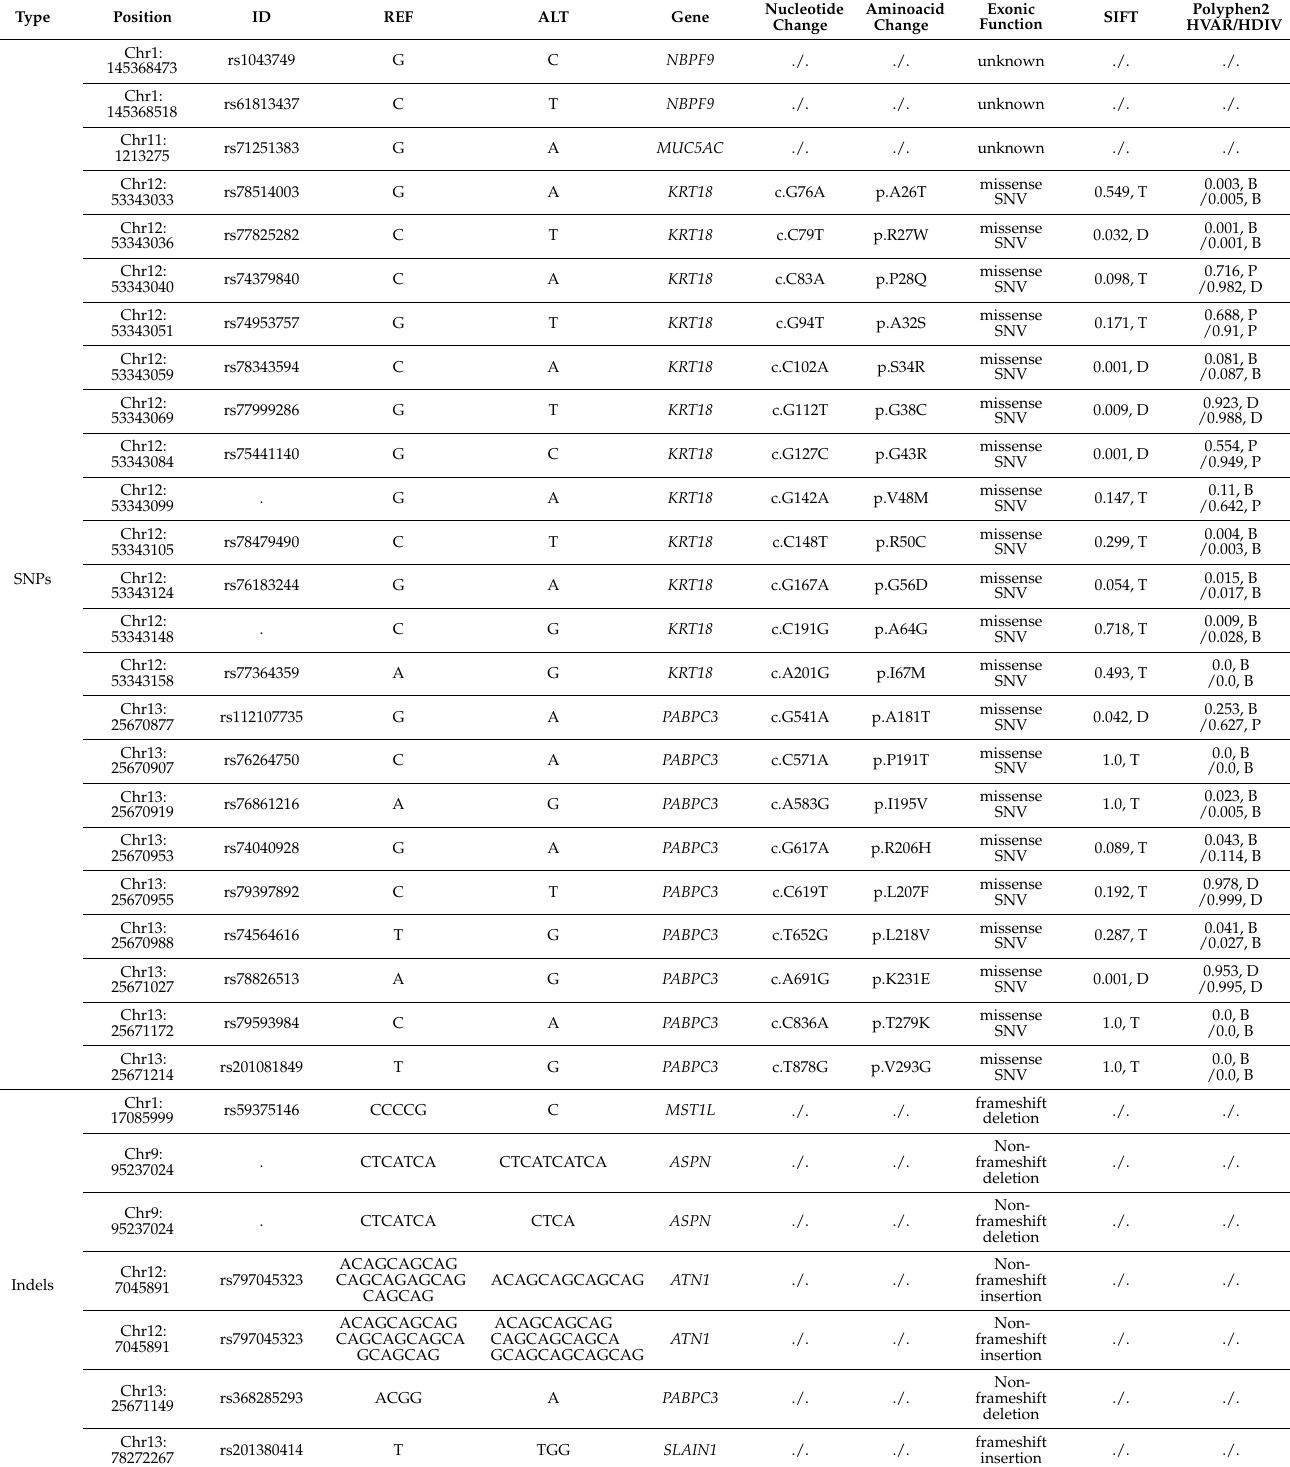
Table 4. Annotation of rare variants with deleterious